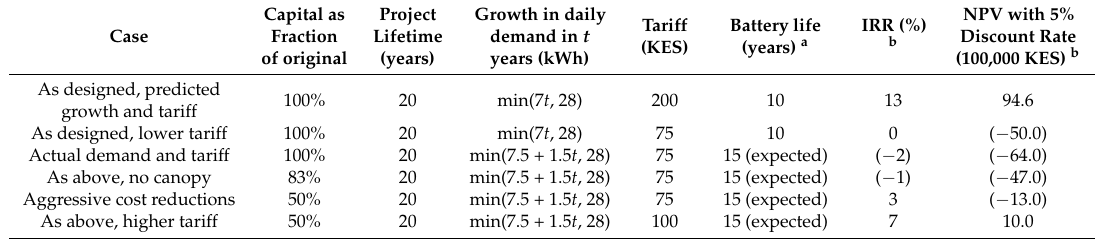
Table 2. Business model assumptions and outcomes under different